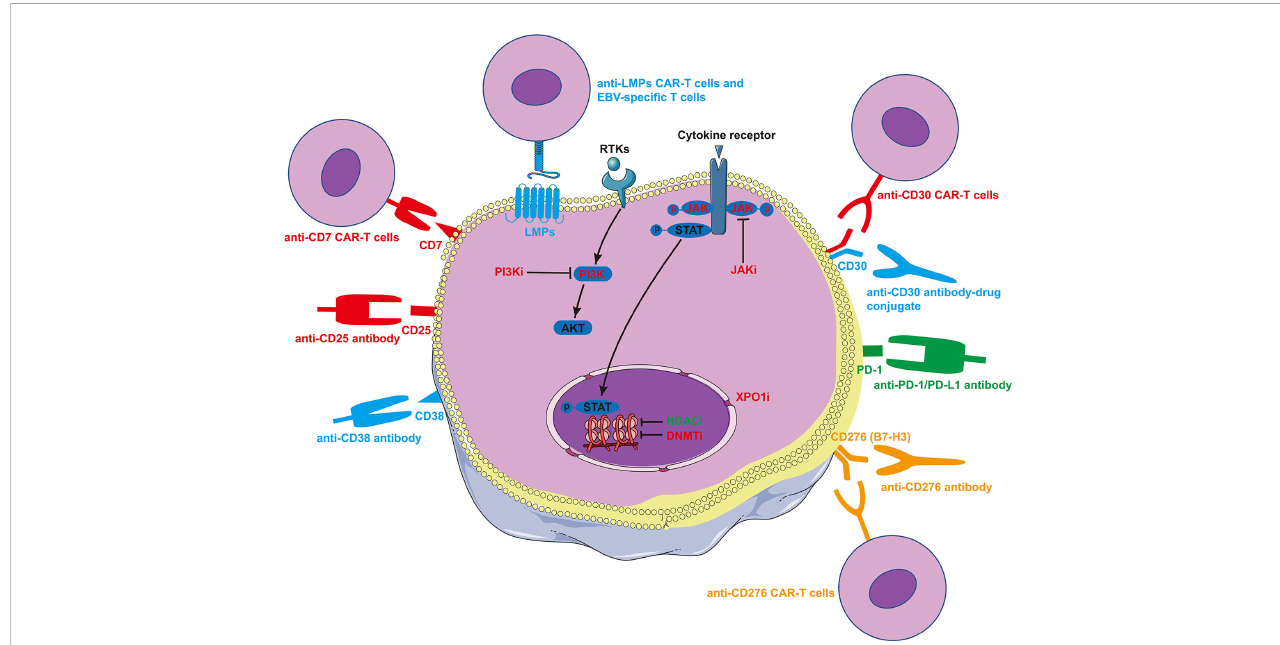
FIGURE 7 Schematic illustration of targeted therapies in ENKTCL. Green indicates that the targeted therapies have been widely used in practice; cyan indicates that the therapies are being investigated in early-stage clinical trials; orange indicates that the therapies have shown activity in animal models; and red indicates that the therapies are currently under investigation in clinical